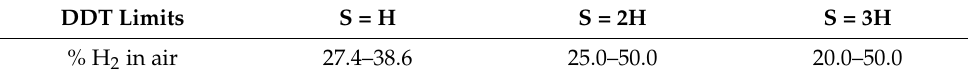
Table 1. DDT limits observed experimentally in 4-m long tube [30,31].